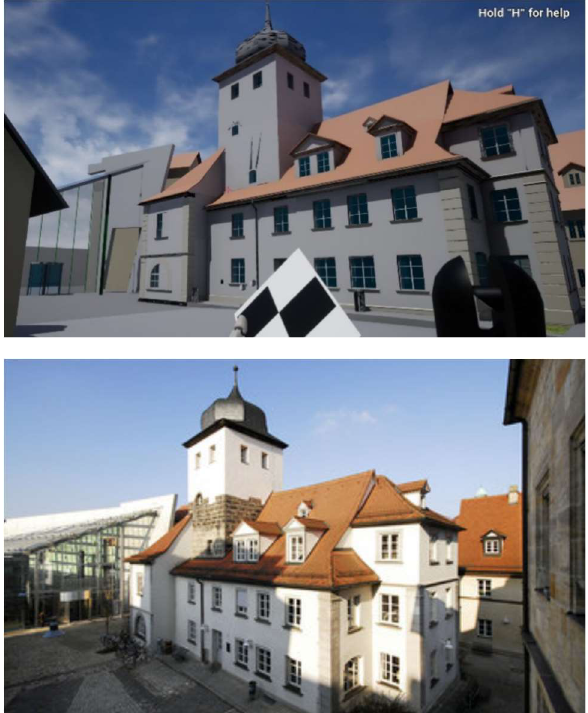
Figure 8. Virtual above and real test object below (University